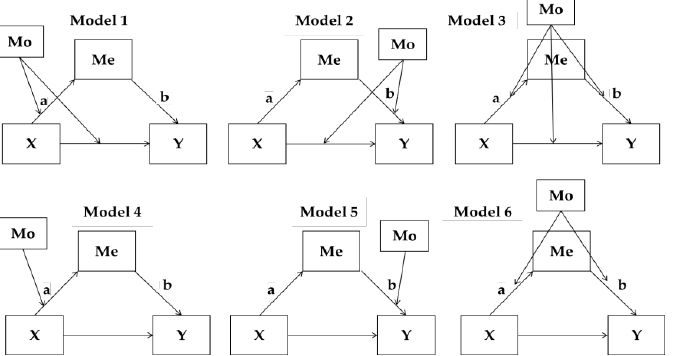
Figure 5. Six different patterns of three models with mediated moderation (Models 1~3) and mod- erated mediation (Models 4~6). The basic equation model for verifying the six models is as follows.